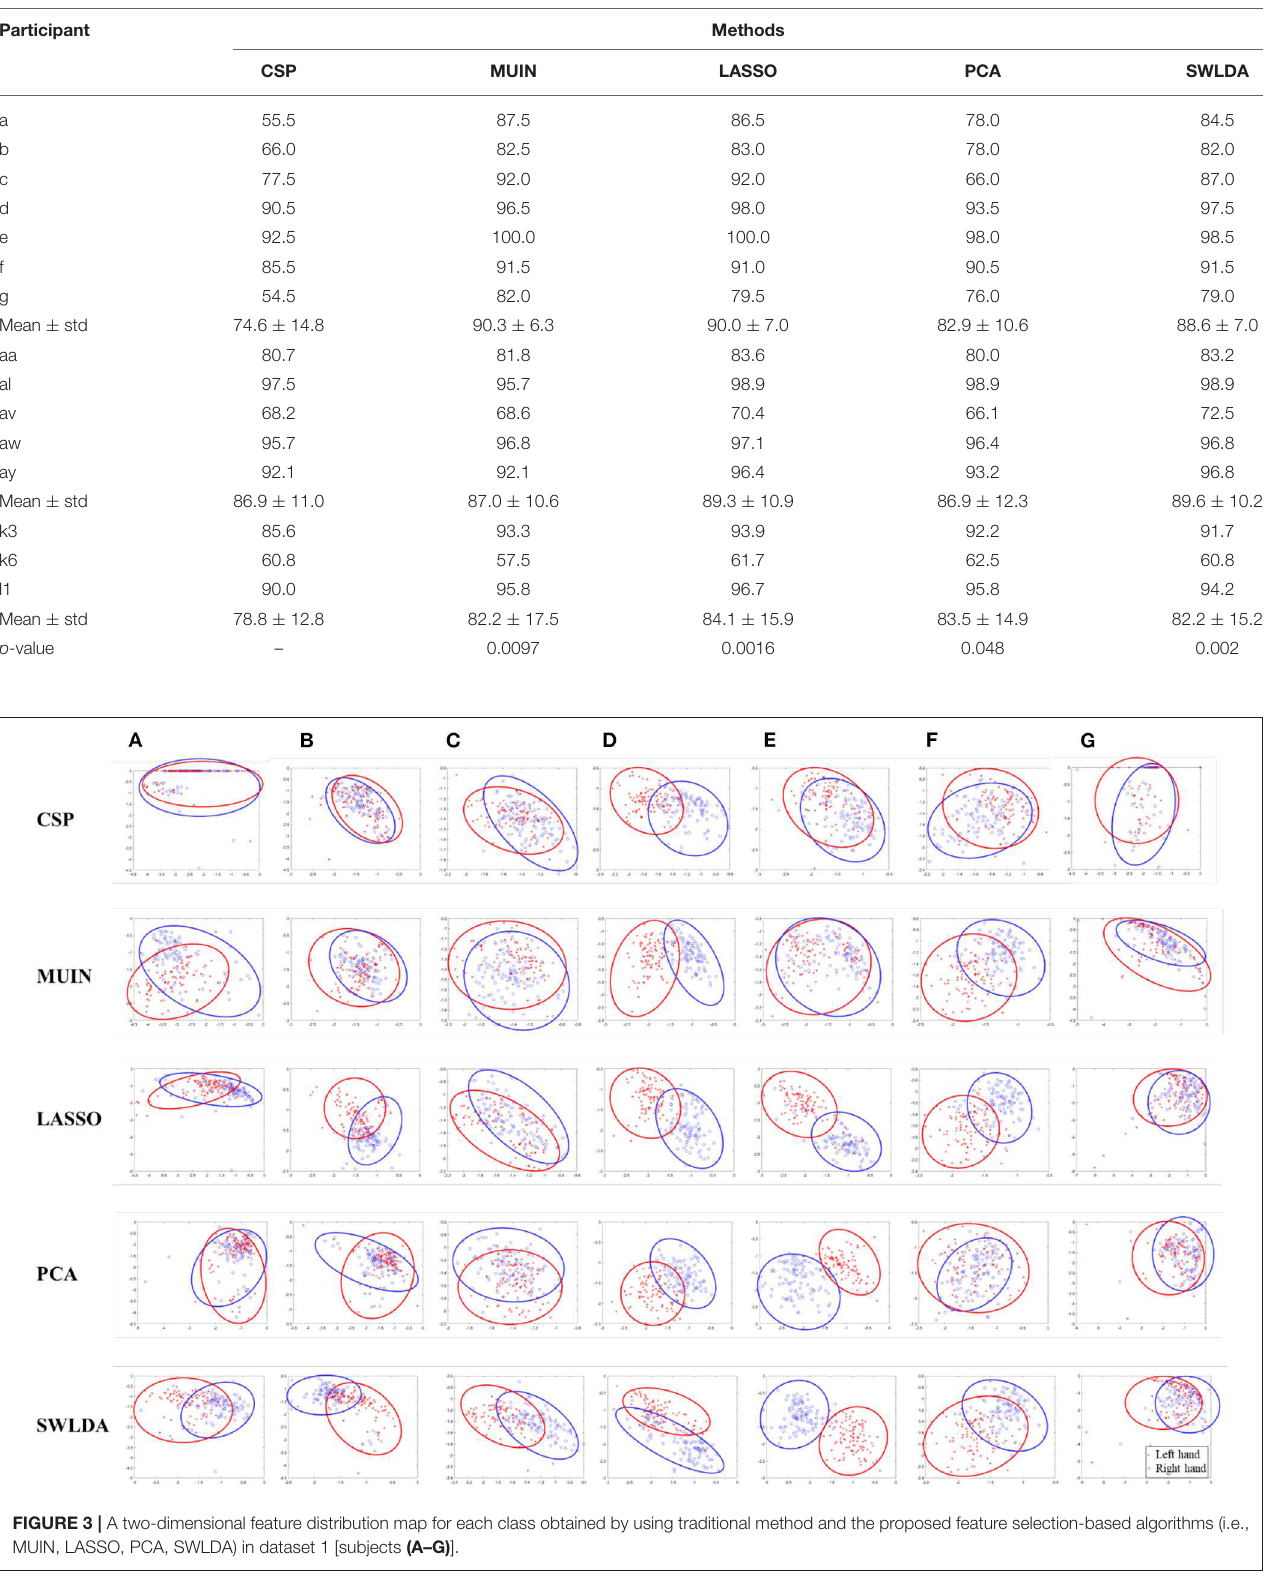
Frontiers in Human Neuroscience |